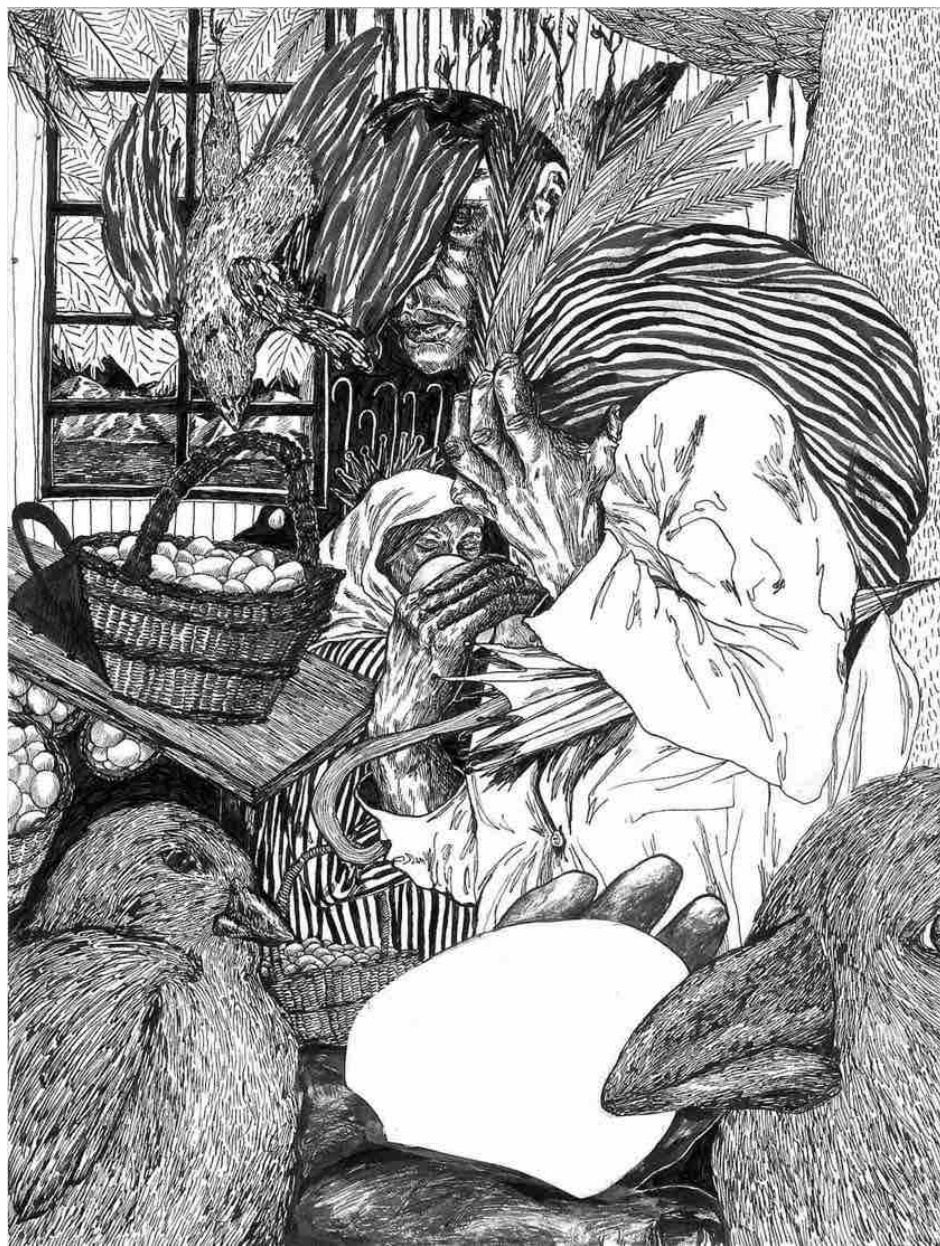
Rosabel Rosalind Kurth-Sofer, Exodus I , 2018. Pen and ink on paper. 9x11